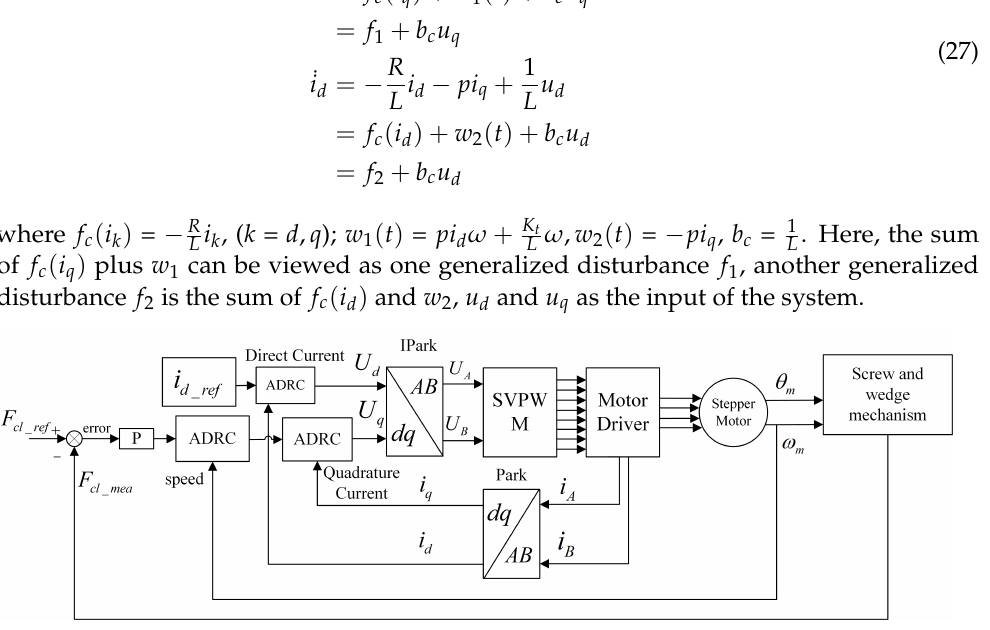
Figure 9. Control block diagram of the proposed EWB